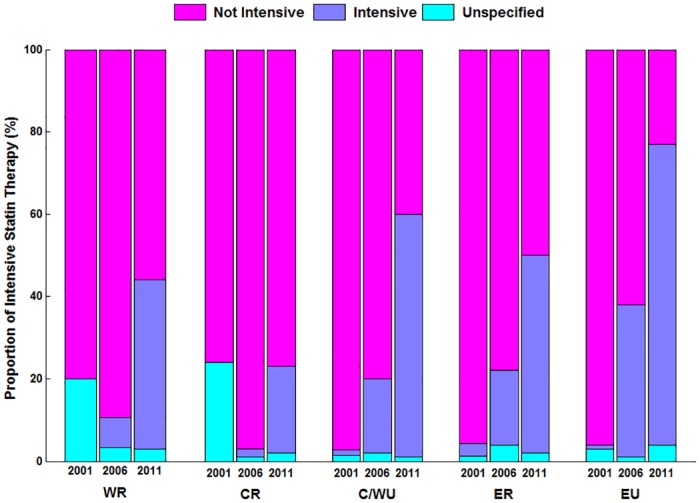
Statin Intensity Therapy among Patients with Statin Therapy Stratified by Region.P for trend <0.001 for the proportion of intensive statin therapy in different regions. WR indicates Western rural; CR indicates Central rural; ER indicates Eastern rural; C/WU indicates Central/Western urban; EU indicates Eastern urban.